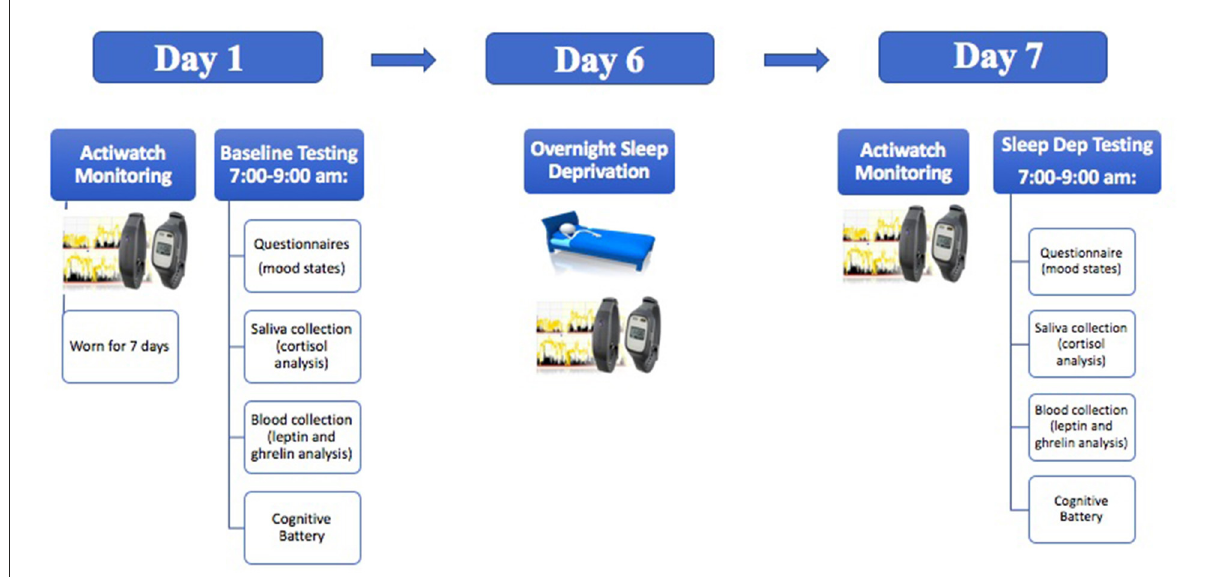
FIGURE1 A schematic illustration demonstrating the experimental timeline.